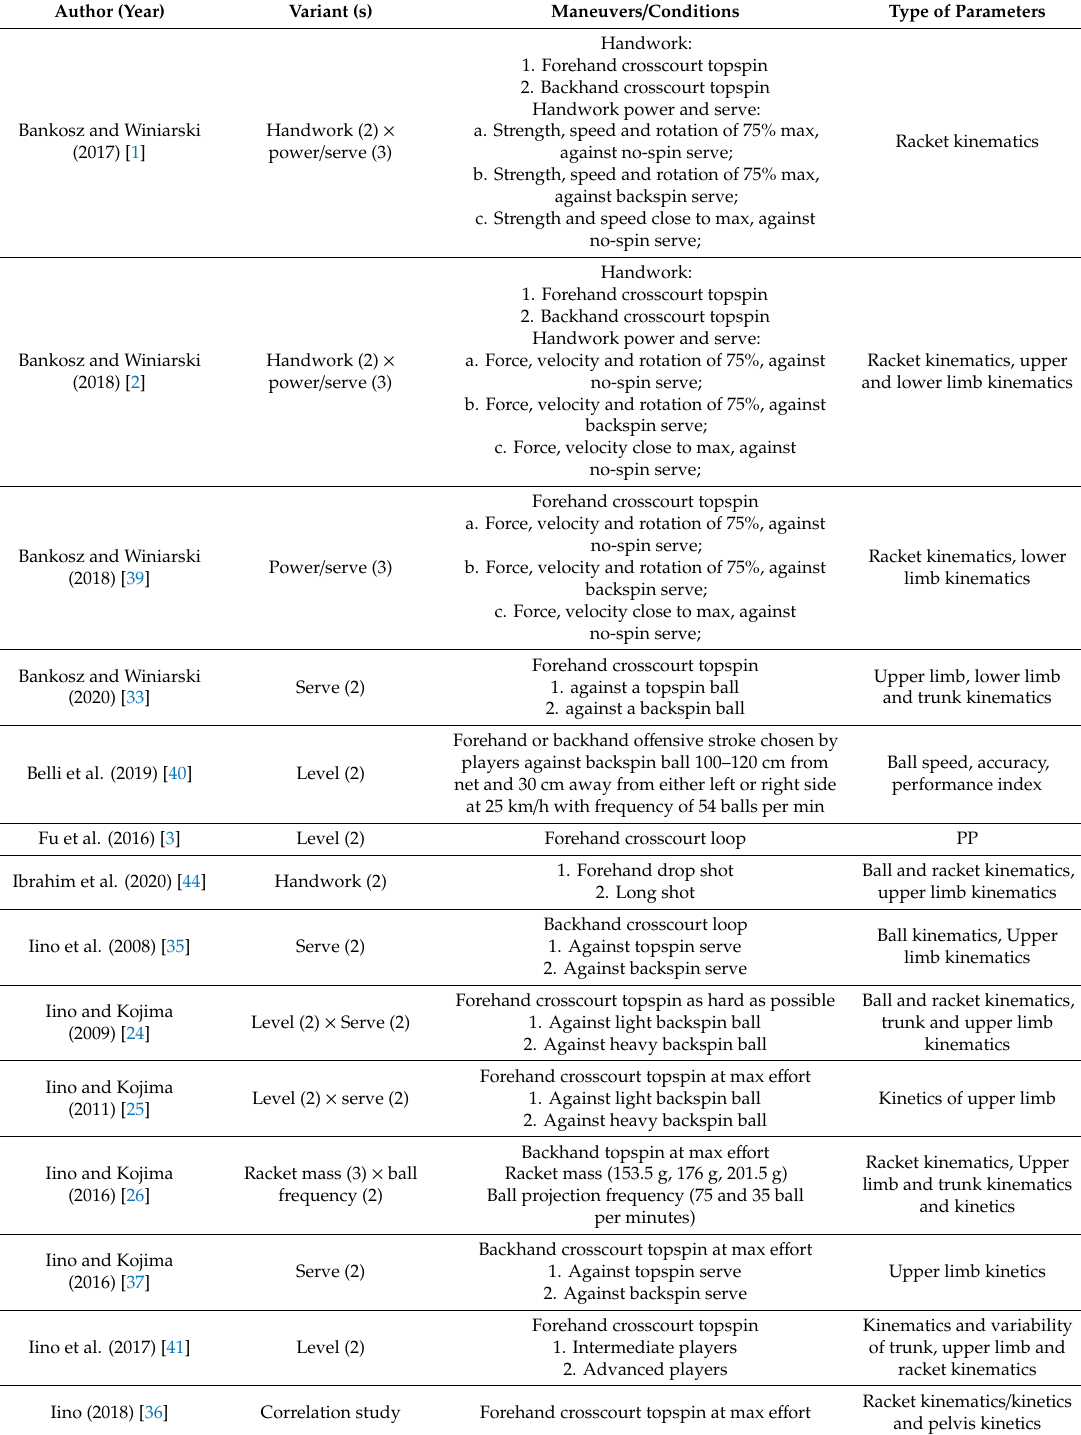
Table 2. Study characteristics of reviewed